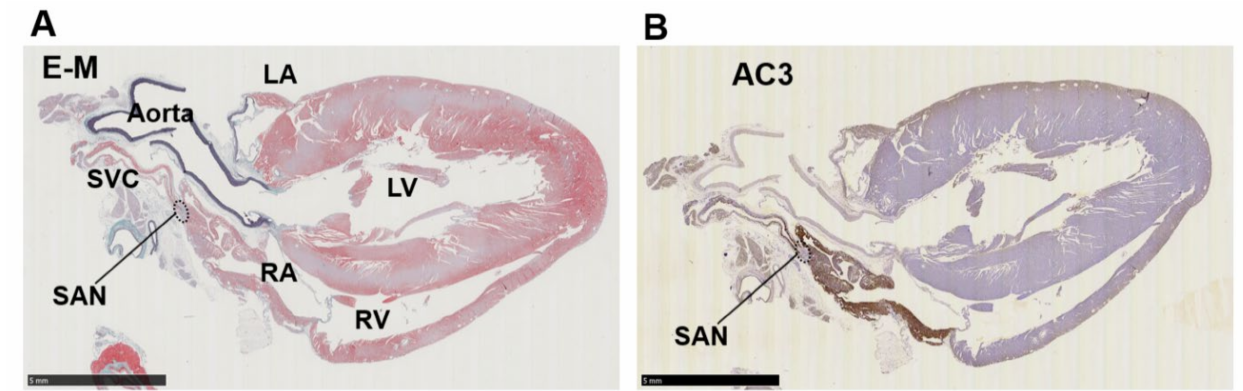
Figure 3. Immunohistochemistry of a right-sided rat heart for adenylyl cyclase AC3. ( A ) Masson’s trichrome staining. LA, left atrium; LV, left ventricle; RA, right atrium; RV, right ventricle, SAN, sinoatrial node; SVC, supra vena cava. ( B ) Immunohistochemistry for AC3. The supraventricular area except the SAN is stained positive. Scale bars: 5 mm.